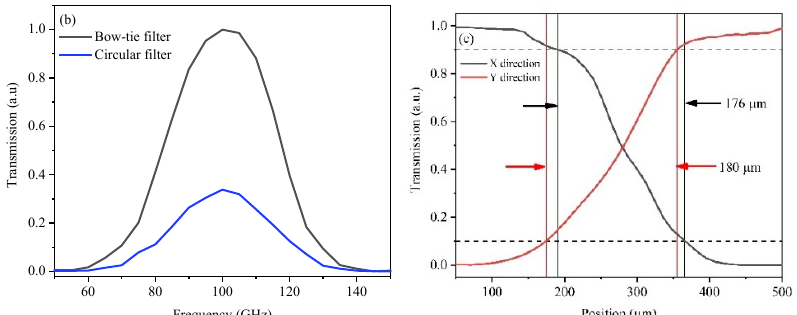
Figure 2. ( a ) Schematic illustration of a circular filter and a bow-tie filter. ( b ) The measured transmission-enhancement factor of the bow-tie filter normalized to the circular filter. ( c ) The measured spatial-resolution curves in the x and y directions of the bow-tie filter.